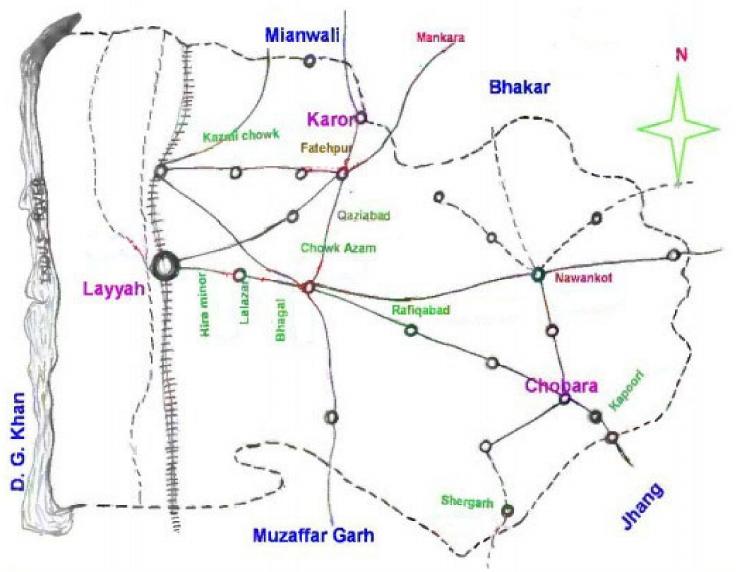
Figure 3. Case study areas within a riverine belt of district Layyah. Reprinted from the ref.